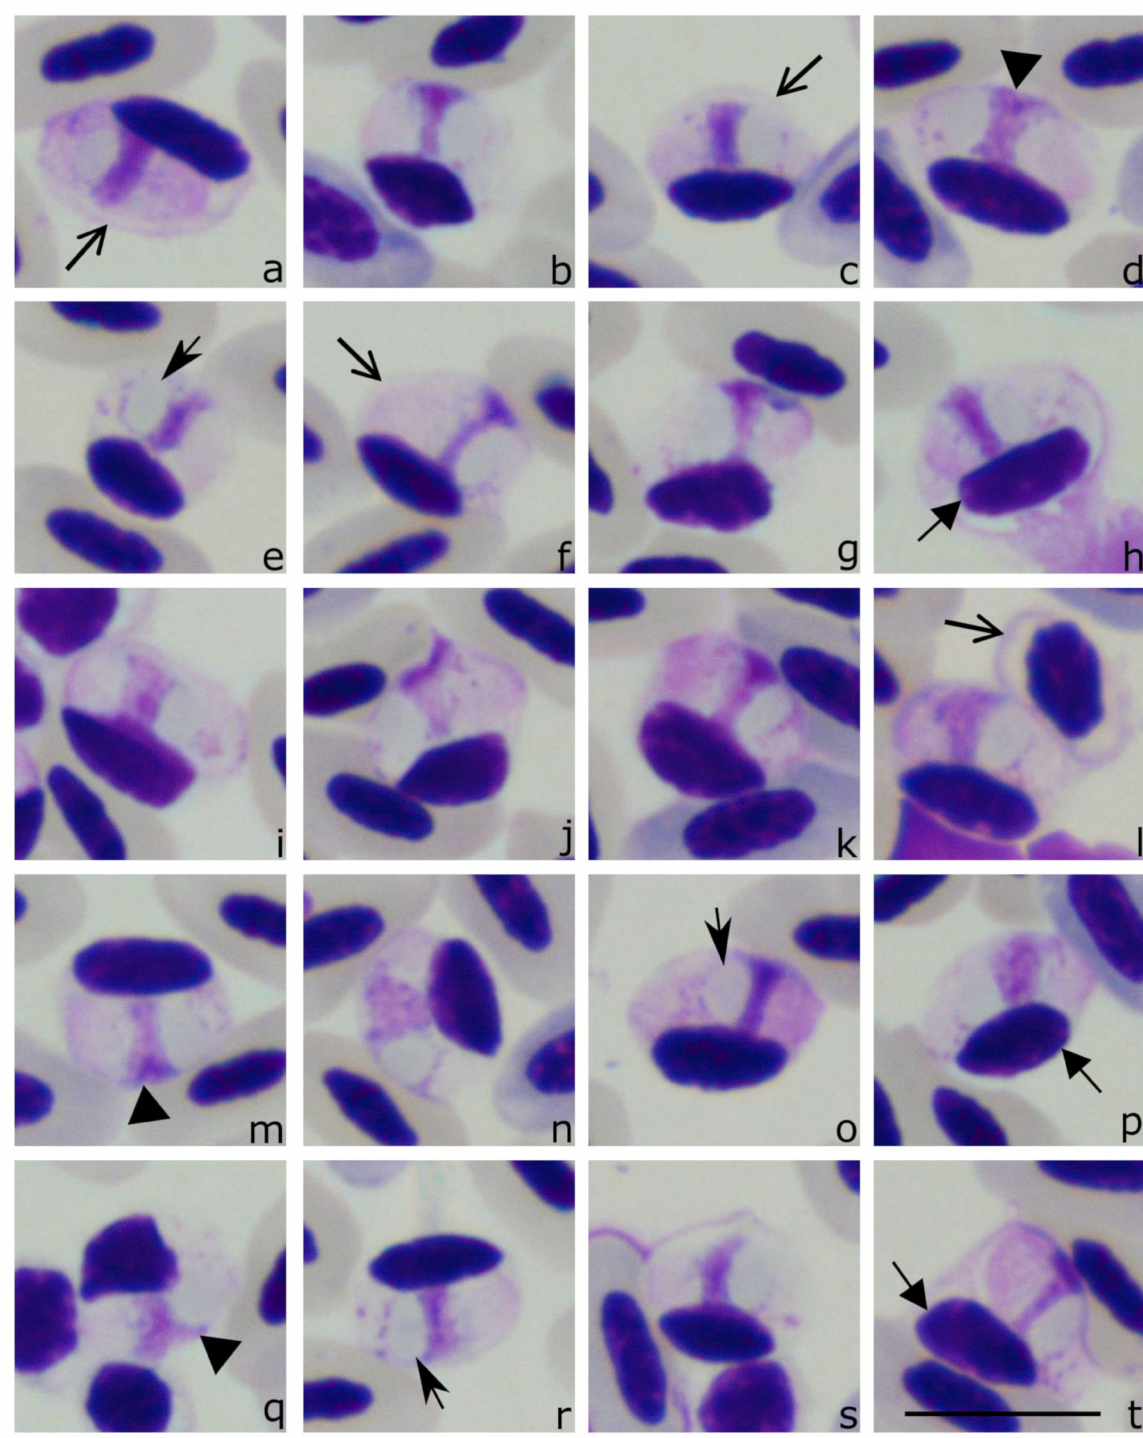
Figure 5. Sporozoites ( a – t ) of Lankesterella macrovacuolata n. sp. 18S rRNA lineage LanParu1 from the great tit Parus major . The parasites develop in thrombocytes ( l ), in which host cell identity is readily distinguishable due to the non-stained cytoplasm ( a , c , f ) and relatively thick cell envelope ( a , f ). Note that the sporozoites are closely appressed to the host cell nuclei, which are displaced to the envelope of the host cells ( b , e , h , p , r ). The presence of a big vacuole-like structure, which is closely appressed to the parasite nucleus ( e , o , r ) is an important species characteristic. Parasite nucleus is of band-like shape; it occupies the entire width of the sporozoite ( c , d , f , h , j ). Triangle, parasite nucleus. Short, barbed arrow, vacuole-like structure. Short triangle arrow, host cell nucleus. Simple wide arrow, host cell envelope. Scale bar: 10 µ m. Methanol fixed and Giemsa-stained blood